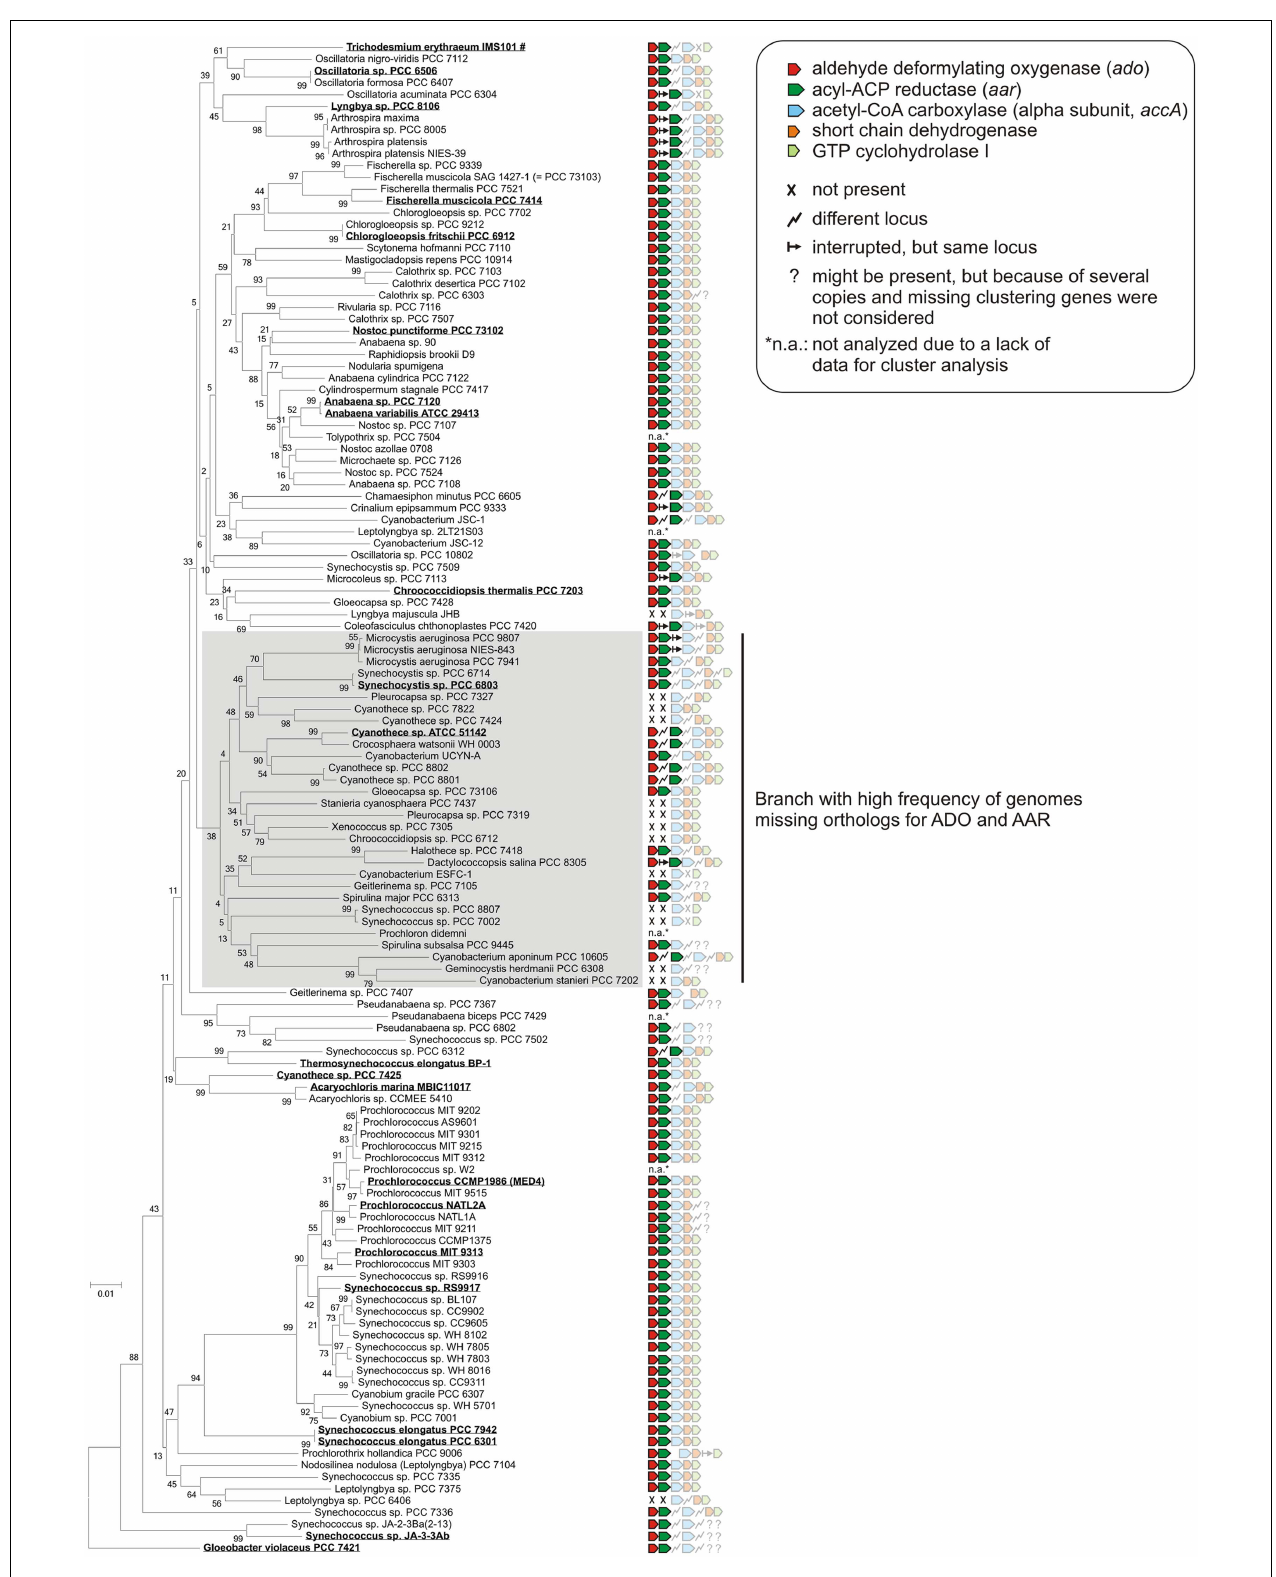
from the SILVA database (Quast et al., 2013). Orthologs of aldehyde deformylating oxygenase and acyl-ACP reductase were searched by using